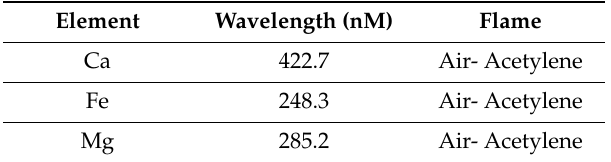
Table 1. Required parameters for the detection of Ca 2 + , Fe 3 + and Mg 2 +